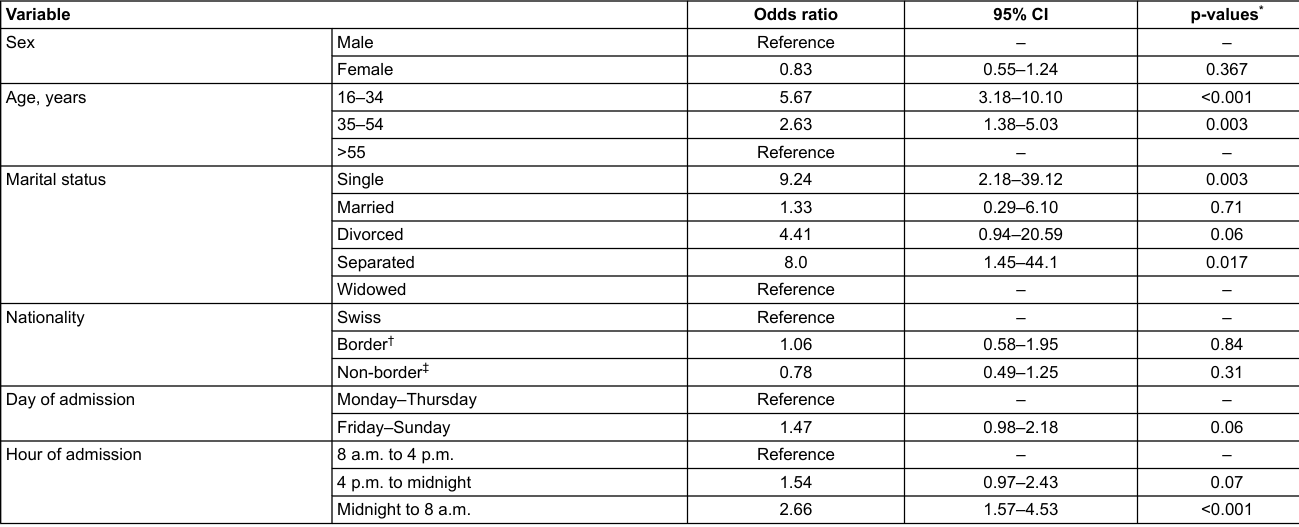
Table 2: Odds ratio tests of surveyed patients’ sociodemographic characteristics